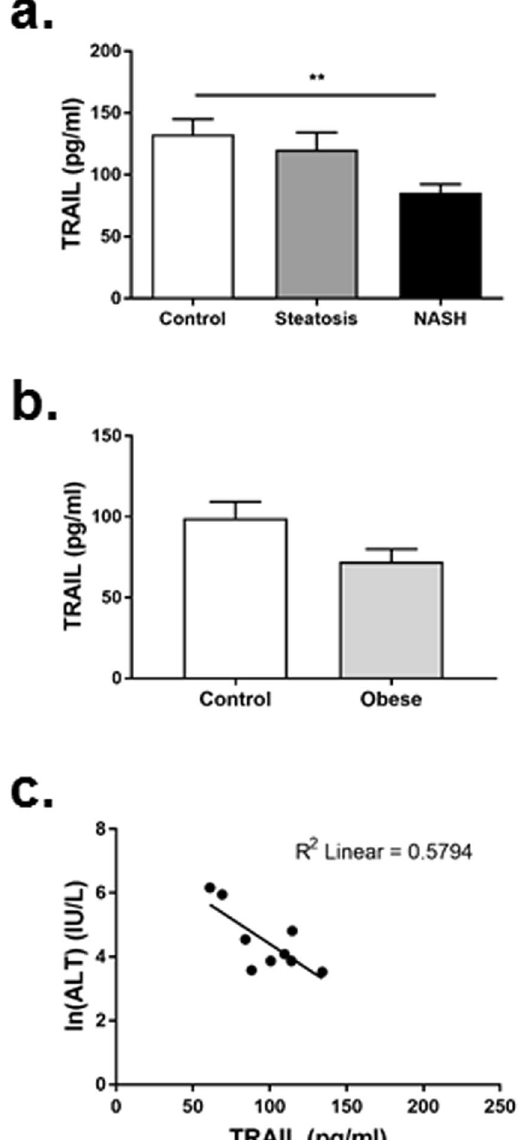
Figure 1. Patients with NASH have reduced circulating TRAIL. ( a ) Circulating TRAIL levels in control, steatosis or NASH patients. ( b ) Circulating TRAIL levels in control and obese individuals. ( c ) Correlation between plasma TRAIL and ALT levels (Spearman rho − 0.516, p = 0.003). Natural log (ln) of serum ALT presented graphically. n = 9–10/group; ANOVA and Mann Whitney U